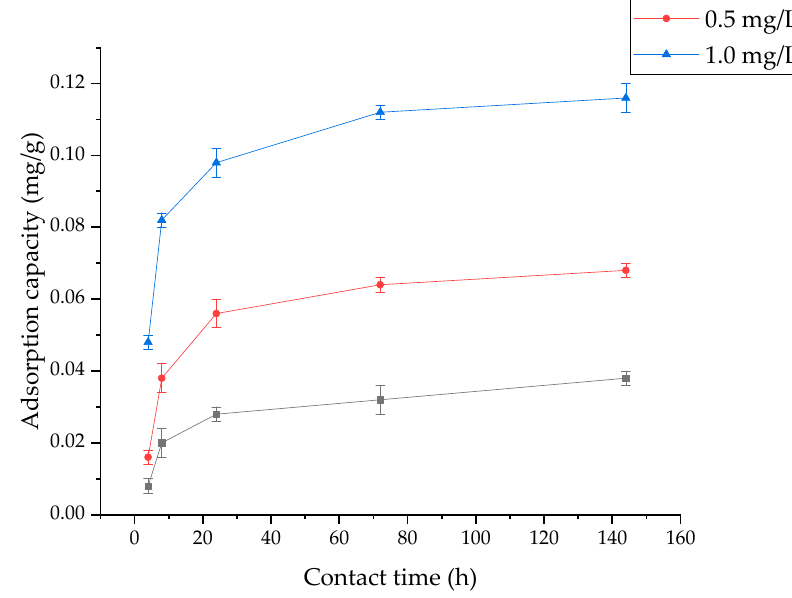
Figure 8. Effect of initial concentrations on the absorption of phosphorus. Figure 8. E ff ect of initial concentrations on the absorption of